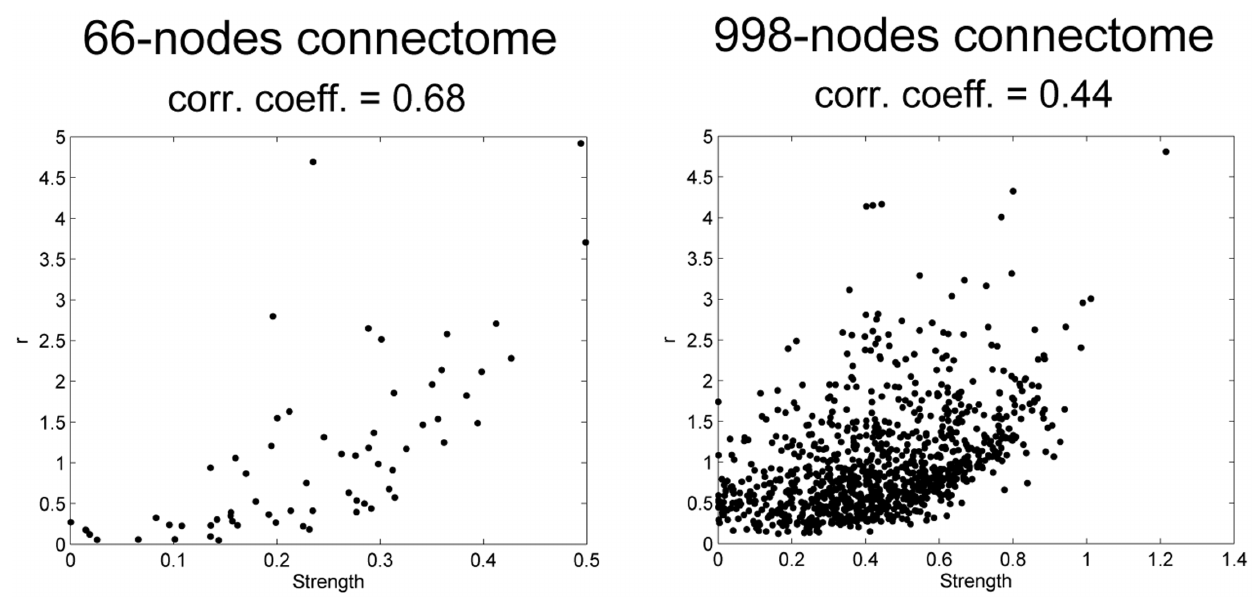
Figure 2. Ratio r of outgoing and incoming information per node at criticality. r is depicted as a function of the nodes strength for both 66 and 989 nodes connectome.